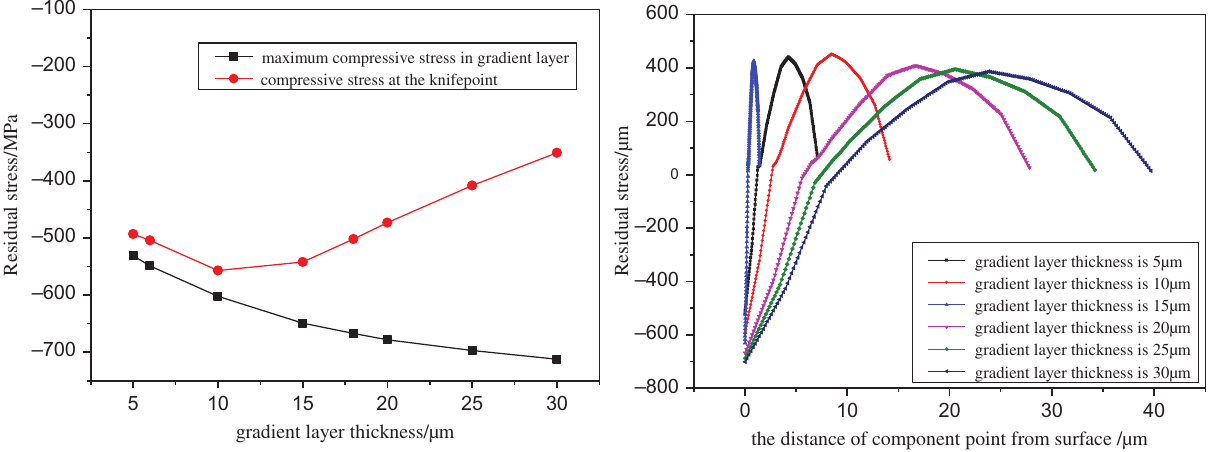
Figure 14: The effect of gradient layer thickness on residual stress (a) compressive stress, (b) residual stress in the gradient